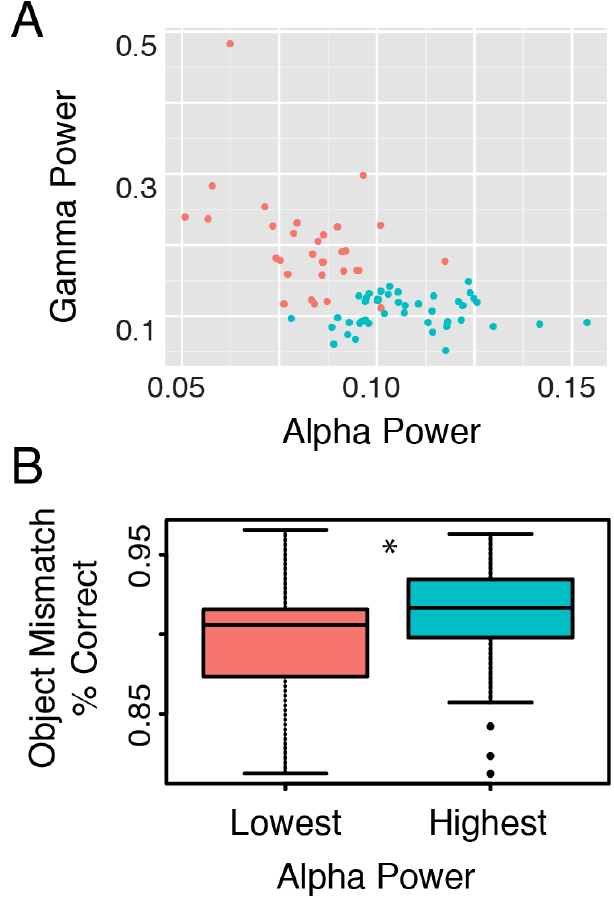
Figure 5. Unsupervised clustering of data based on neural activity results in clusters with significant differences in cognitive performance. k -means clustering resulted in 10 clusters that were divided in half based on mean alpha power. (A) The top (cyan) and bottom (orange) clusters visually separated in gamma and alpha dimensions. (B) The scores on Object Mismatch for the two clusters were significantly